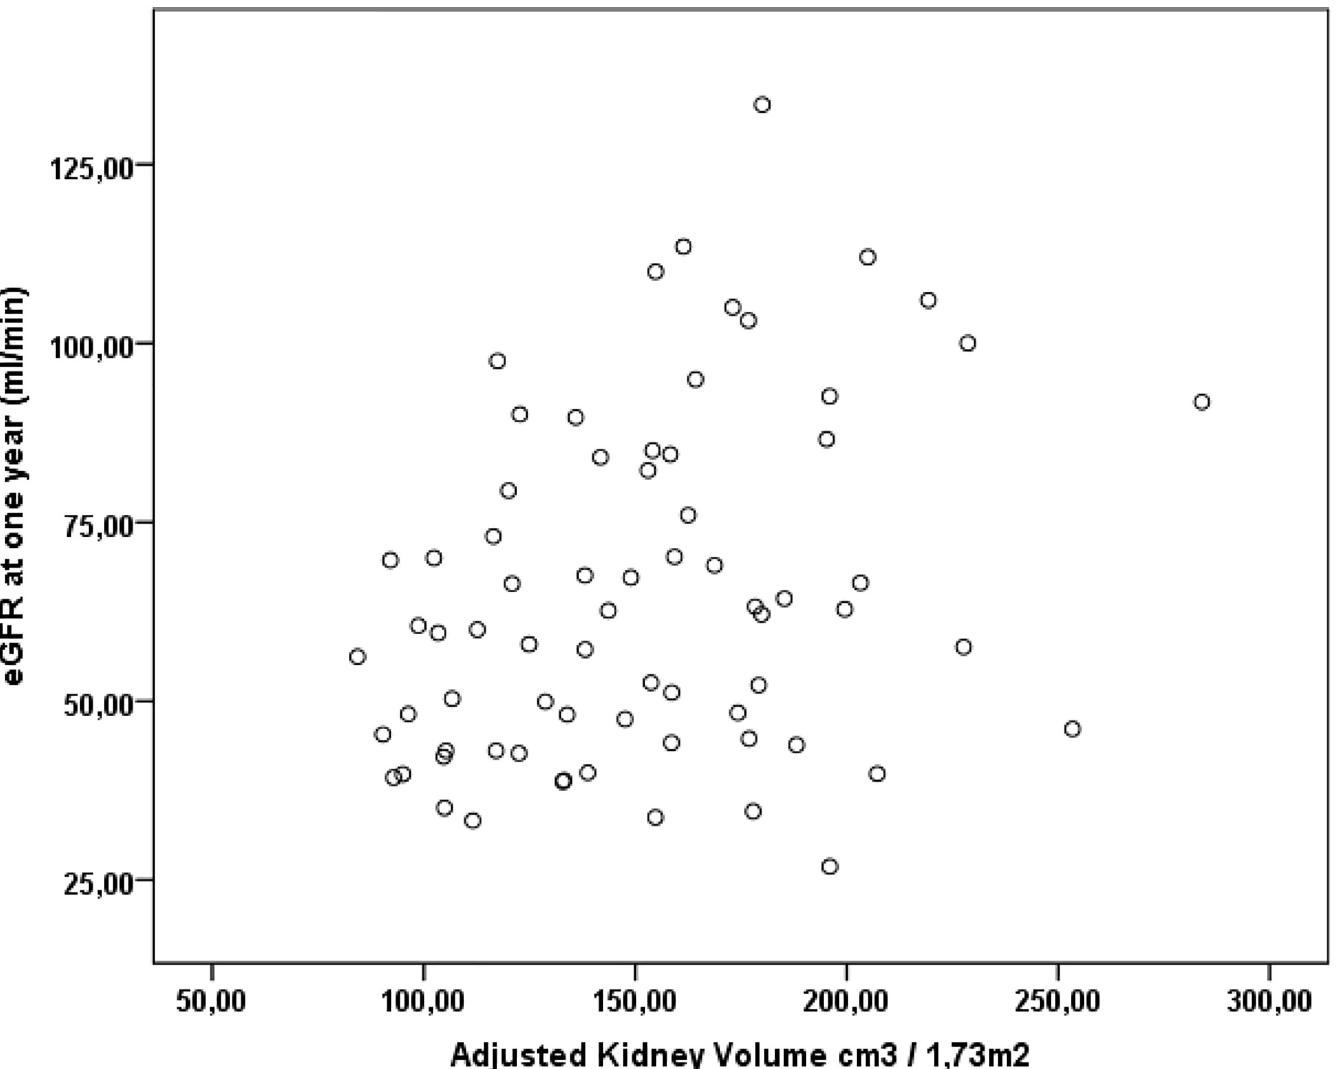
Fig 1. Correlation between adjusted kidney volume and glomerular filtration rate (eGFR) at 1 year in living donors (r = 0.311, p = 0.008).